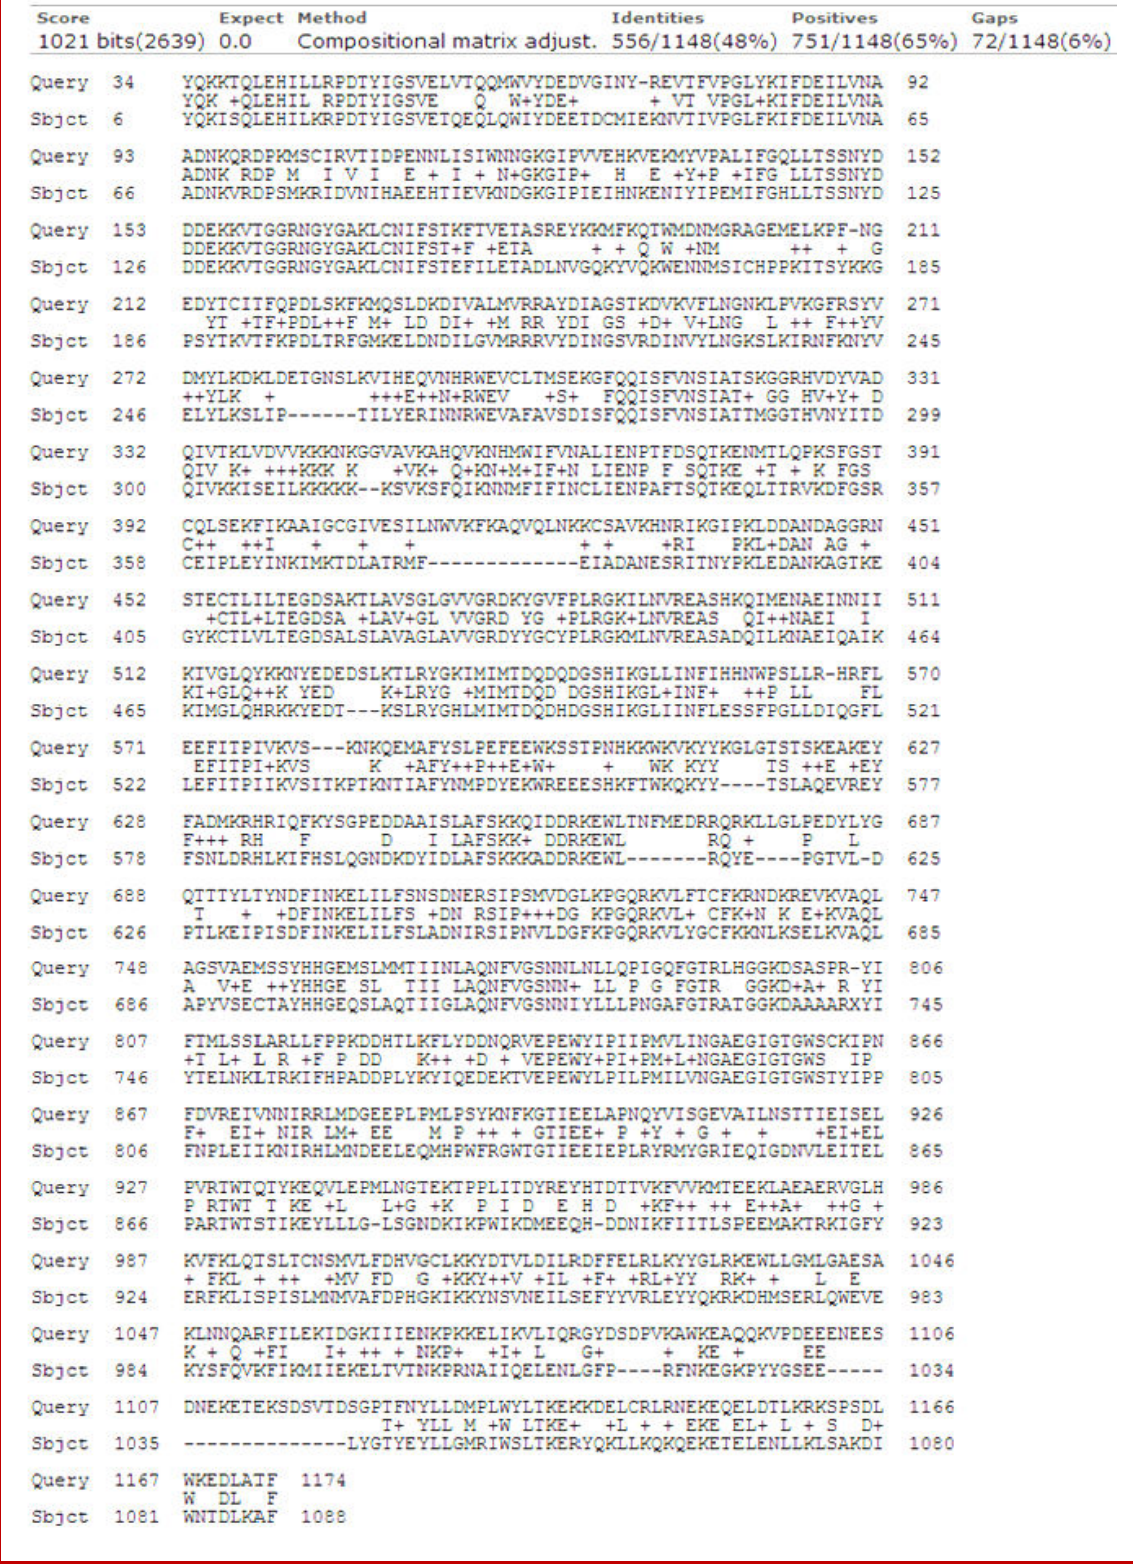
Figure 1: Sequence alignment between query (topoisomerase II (cid:450)) of human and subject (4GFH